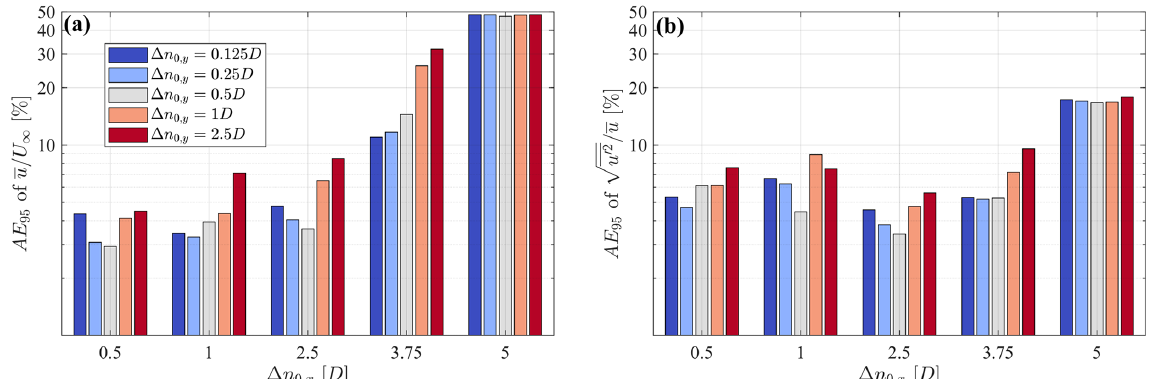
Figure 19. AE 95 of the statistics reconstructed from virtual lidar data for different streamwise and spanwise fundamental half wavelengths, for the setup (cid:49)θ = 2 . 5 ◦ − σ = 1 / 4. (a) Mean streamwise velocity. (b) Streamwise turbulence intensity.